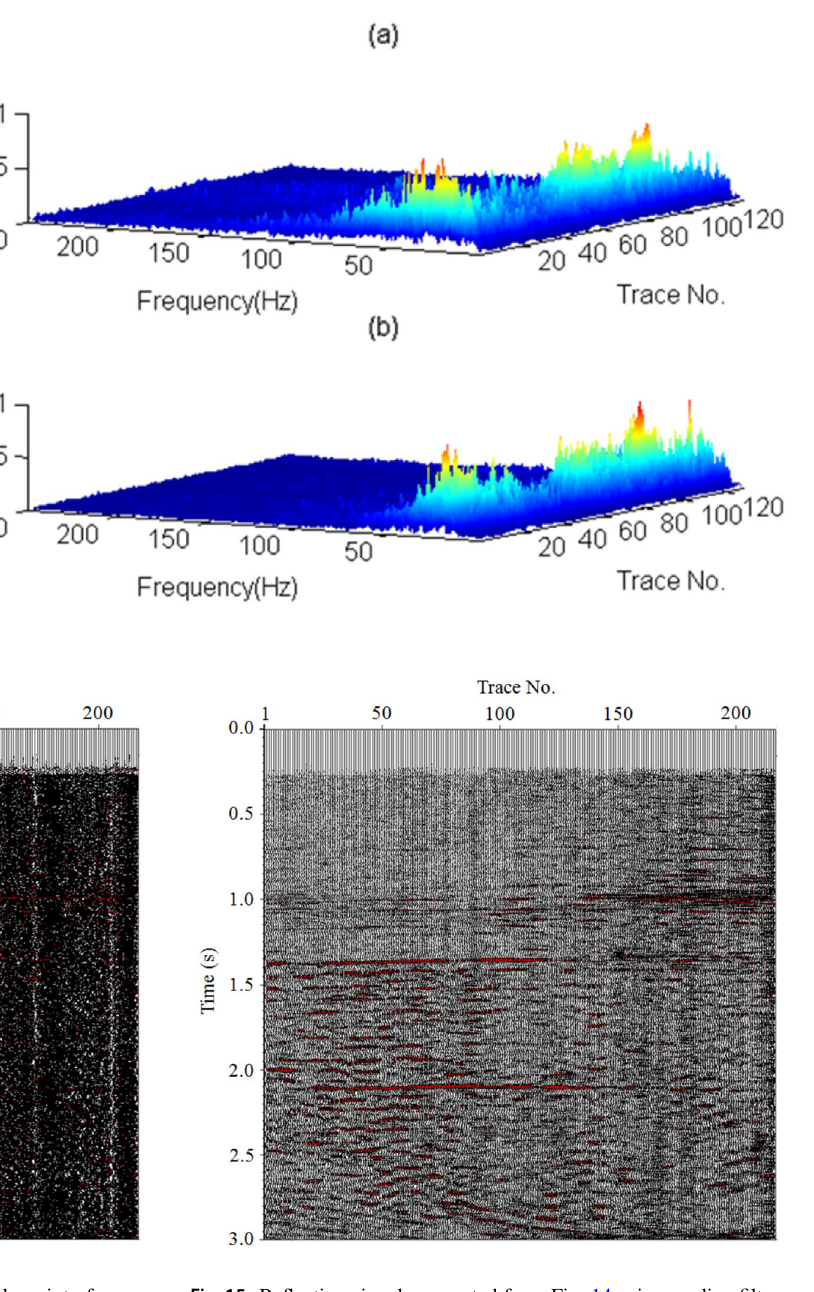
Fig. 14 A stacked section contaminated with random interference noise. Random noise is the main factor that affects the quality of the section